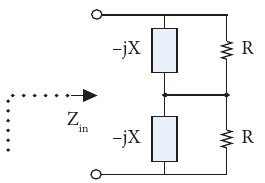
Figure 5: Te modifed RCN (two identical reactance components).